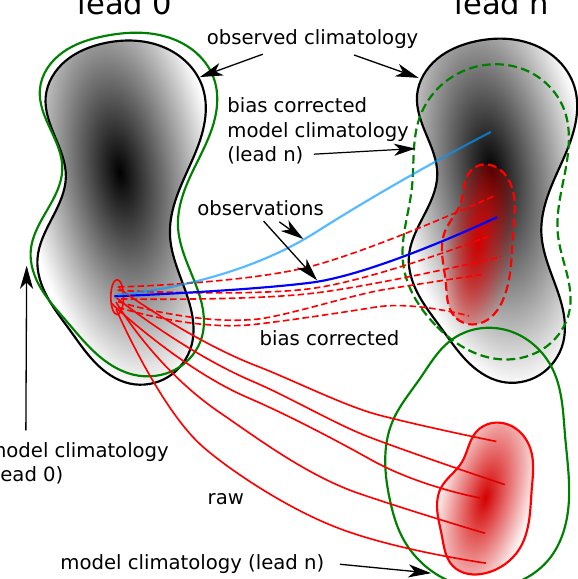
Figure 1. Schematic of a forecast ensemble with biases. The shaded grey area represents the climato- logical space of the target variable as defined by past observations, with darker shading indicating regions that are occupied more frequently. The area inside the green line on the left represents the cli- matological space of the target variable at lead 0 defined by many past forecasts in the forecast model. The current forecast is initiated in the red ellipse around the point in climatological space where the target variable is observed to start. The forecast ensemble members follow the solid red lines and land in a region of climatological space (red shading inside solid red line) at a given lead time. The forecast climatology of the model at this lead time is defined by many past forecasts at this lead time and is given by the space inside the solid green line on the right. The bias-corrected forecast ensemble members are represented by the dashed red lines and land inside the space enclosed by dashed red lines. The dashed green lines represent the climatology of the bias-corrected forecasts at lead n. The dark/light blue lines represent the observed outcome for a case where this lies inside/outside the bias-corrected forecast